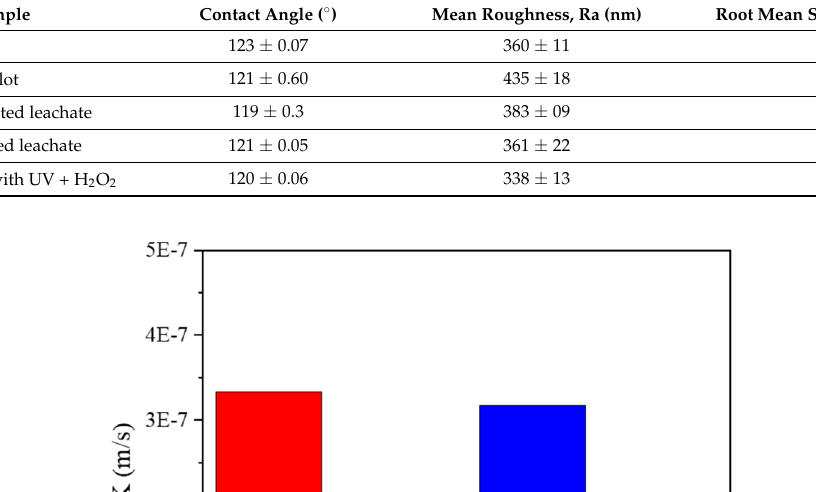
Table 2. Contact angle and roughness parameters for virgin, fouled, and cleaned membrane samples.